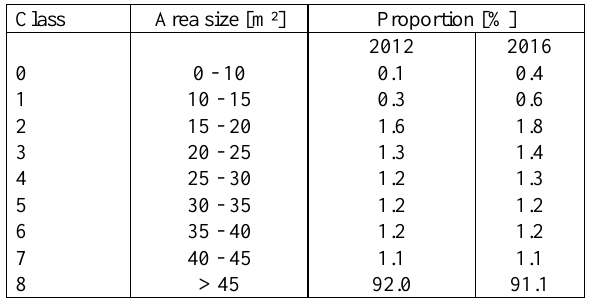
Table 1. Share of the area classes compared from 2012 to 2016 in North-Rhine-Westphalia